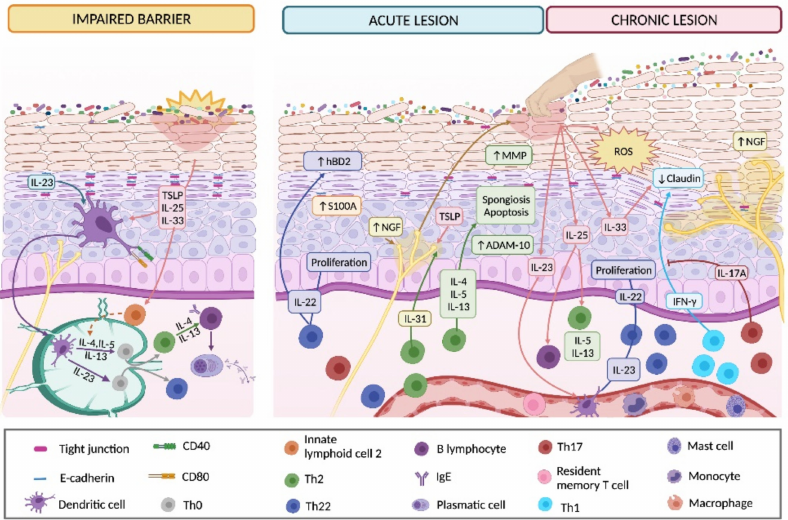
Figure 4. Keratinocyte participation in the onset, development and chronification of atopic dermatitis lesions. Due to an impaired cutaneous barrier, KC-derived cytokines (mainly TSLP, IL-23, IL-25 and IL-33) induce dendritic cell activation and mobilization to nearby lymphatic nodes where they active naïve CD4+ T cell (Th0) and promote Th2 and Th22 polarization. Th2-derived cytokines trigger antibody isotype switching in B lymphocytes to produce IgE. Cytokines produced by Th2 and Th22 cells increase KC proliferation and S100A expression, prompt KC apoptosis and induce cutaneous spongiosis due to a decrease in E-cadherin levels mediated by increased enzymatic activity. These changes are clinically manifested in skin as acute lesions. In this stage, IL-22 and hBD2 mutually enhance their production, perpetuating the inflammatory response associated with AD. Pruritic mediators released by Th2 cells (IL-31) or KCs (NGF and TSLP) increase itching sensation which triggers scratching and worsening of skin lesions. Lesions becomes chronic due to the intensification of the pre-existing Th2 and Th22 inflammatory response enhanced by Th1 and Th17 cytokines. Augmented production of IL-23, IL-25 and IL-33 by KCs maintains Th22 differentiation, up-regulates Th2 cytokine production and diminishes claudin expression, respectively. The decrease in tight junctions, which is enhanced by IFN- γ production, together with the increased levels of NGF, favors epidermal hyperinnervation. Altogether, this inflammatory environment exacerbates the remodeling processes of the epidermis and hyperplasia, while IL-17 down-regulates the IFN- γ effect on claudin expression. Abbreviations: hBD2, human beta-defensin 2; MMP, matrix metalloproteinase; NGF, nerve growth factor. Created with BioRender.com (access date: 26 August